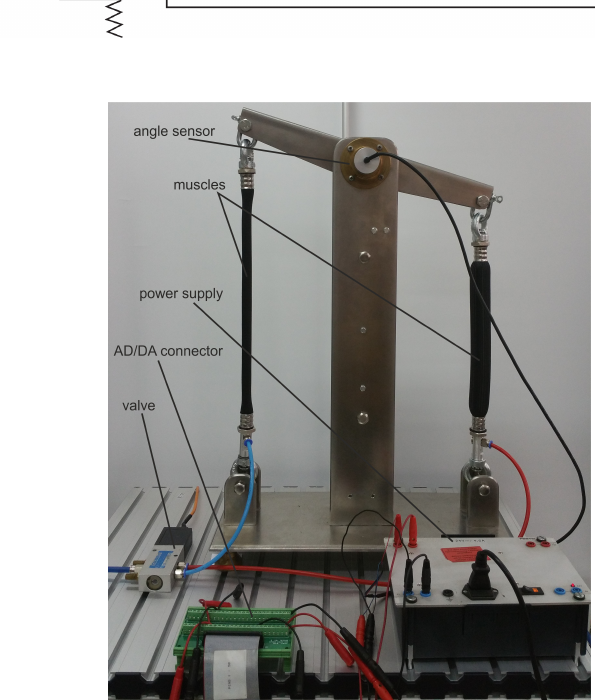
Figure 3: Test stand: a) diagram, b) general